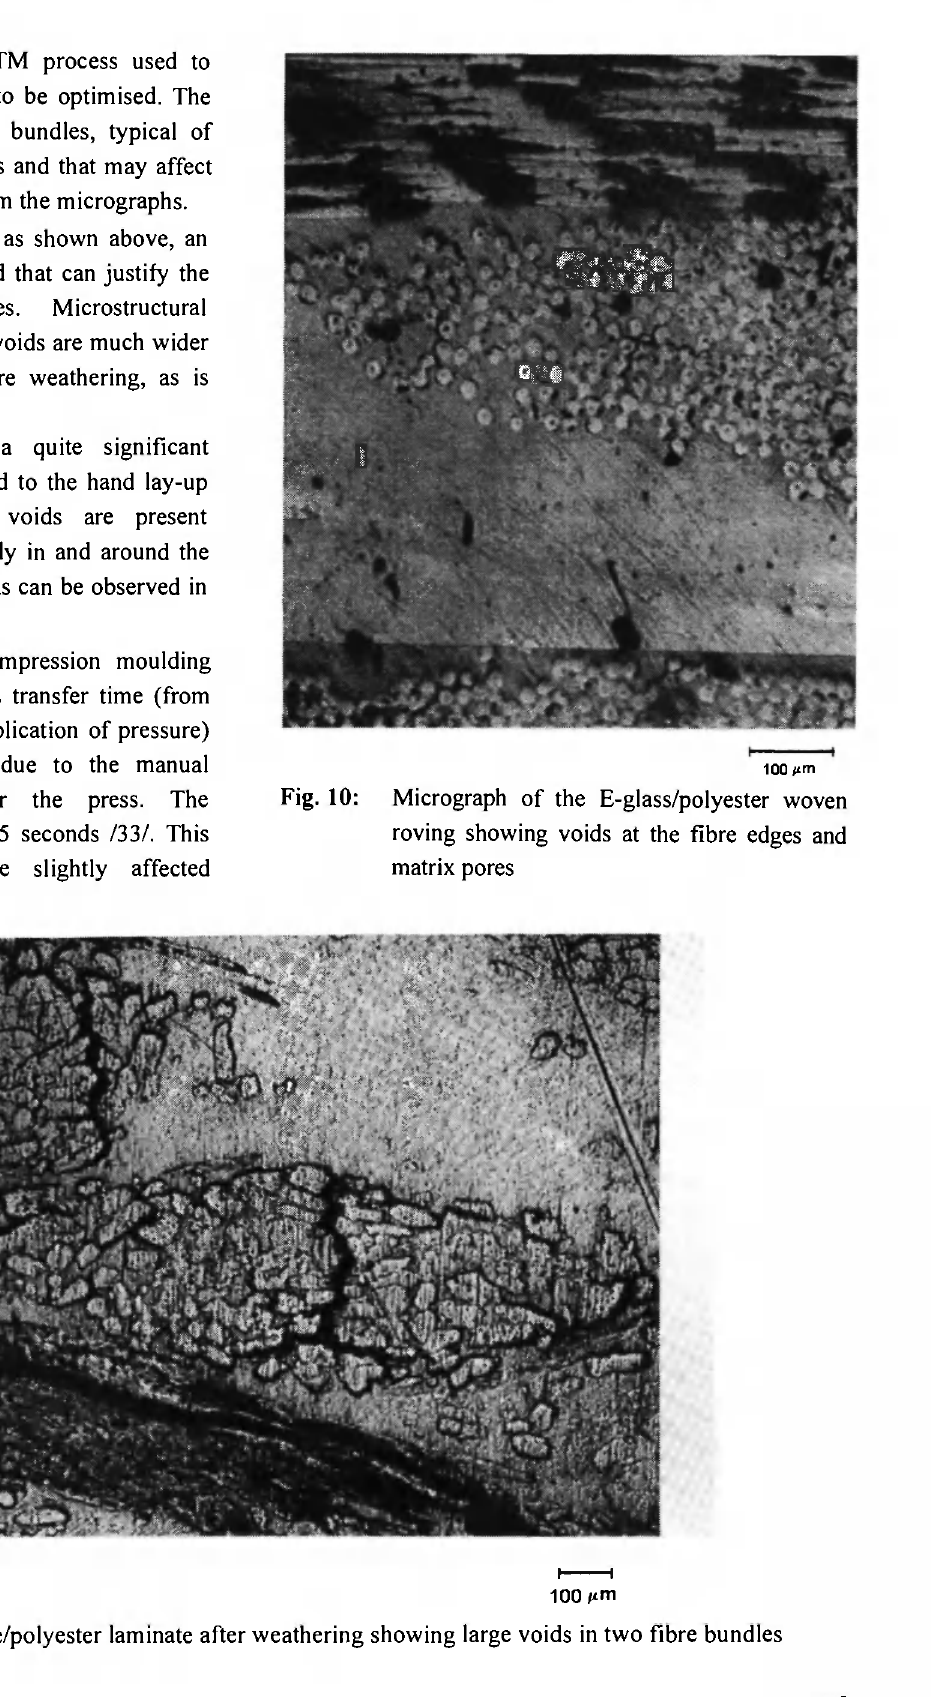
Fig.9: Micrograph of the jute/polyester laminate after weathering showing large voids in two fibre